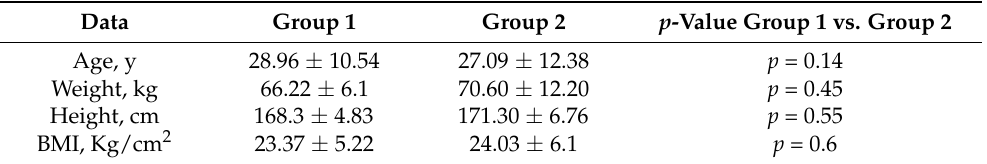
Table 1. Descriptive data of the